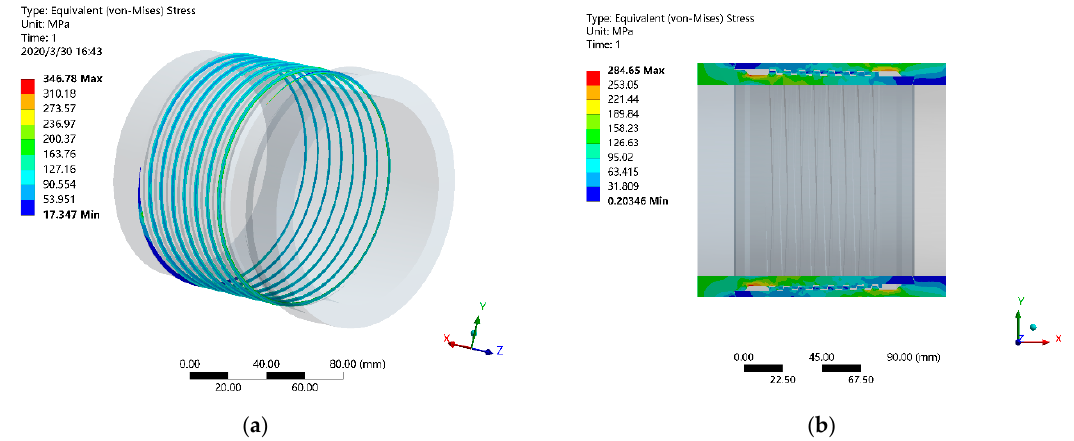
Figure 12. Stress distribution on the thread contact surface under a tensile load of 100 kN: ( a ) contact surface stress and ( b ) cross-sectional stress distribution.